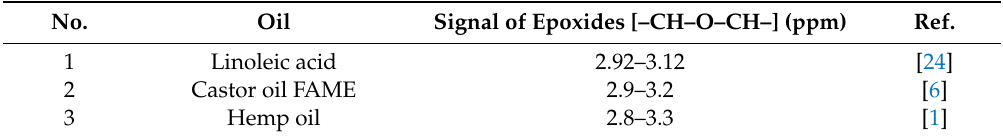
Table 8. 1 H NMR results in an epoxy compound.